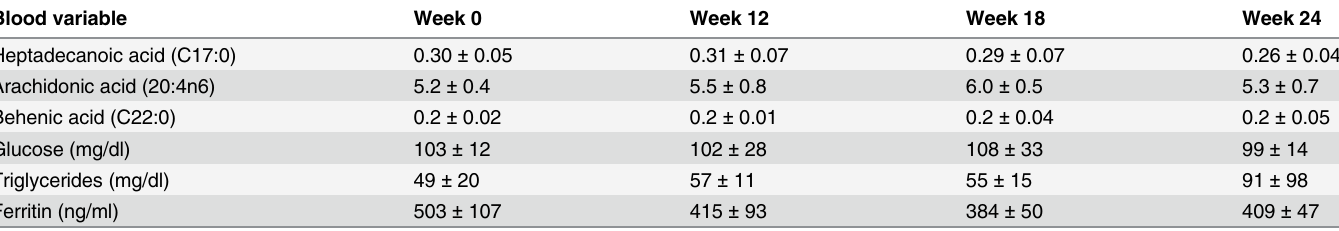
Table 4. Targeted percent serum fatty acids and blood-based metabolic health indices in reference dolphins (n = 4) during 24-week feeding study, comparing values from weeks 12, 18 and 24 to baseline week 0. No values from weeks 12, 18, and 24 were significantly different than week